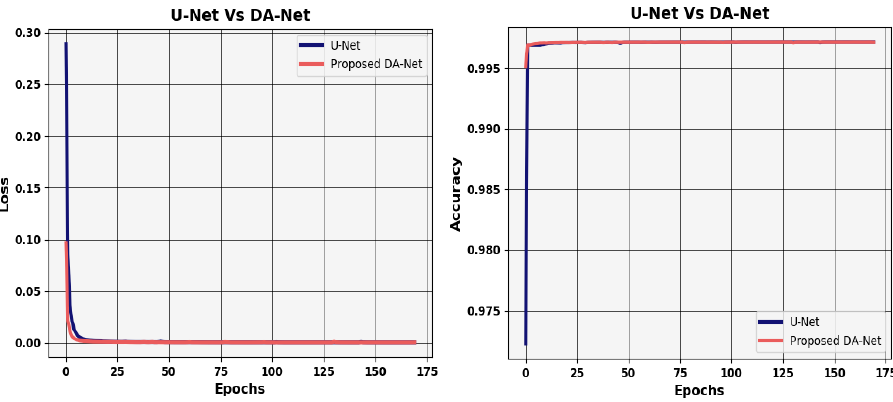
Figure 8. Accuracy and loss graphs of both DA-Net and